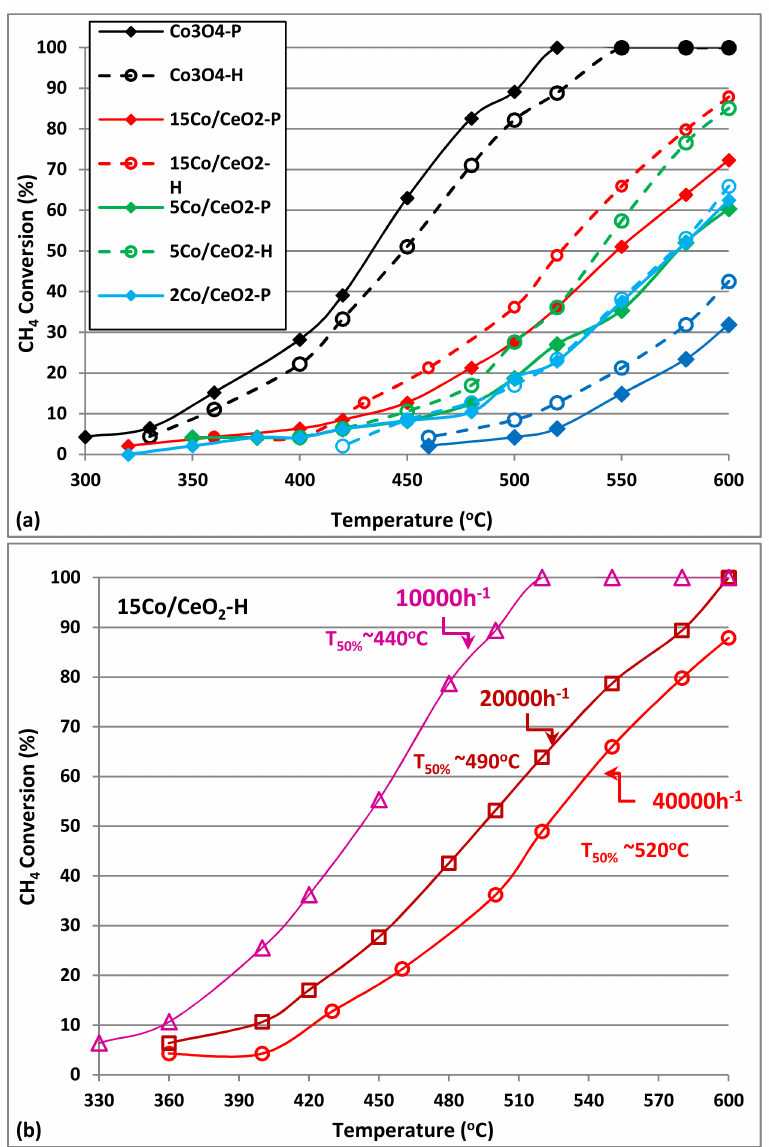
Figure 6. Catalytic performance in complete CH 4 oxidation on pure CeO 2 , Co 3 O 4 and nanocomposite Co/CeO 2 catalysts. ( a ) CH 4 conversion vs. temperature Flow rate: 900 cm 3 /min; GHSV~40,000 h − 1 ; ( b ) Effect of WHSV on CH 4 conversion for the optimum selected 15Co/CeO 2 -H catalyst. Feed: 0.5% vol. CH 4 and 10% vol. O 2 , balanced with